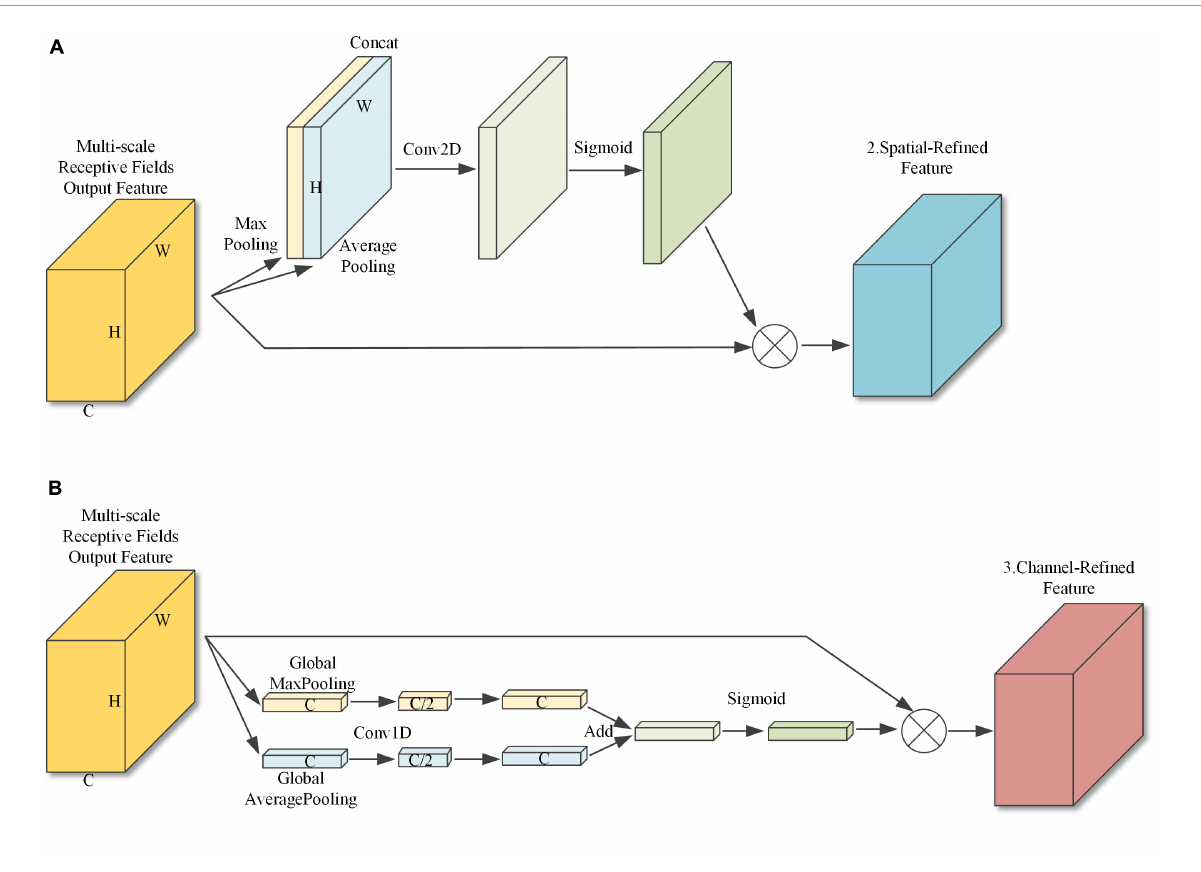
FIGURE7 Parallel attention module. (A) Sub-module 2: Spatial attention module. (B) Sub-module 3: Channel attention module.